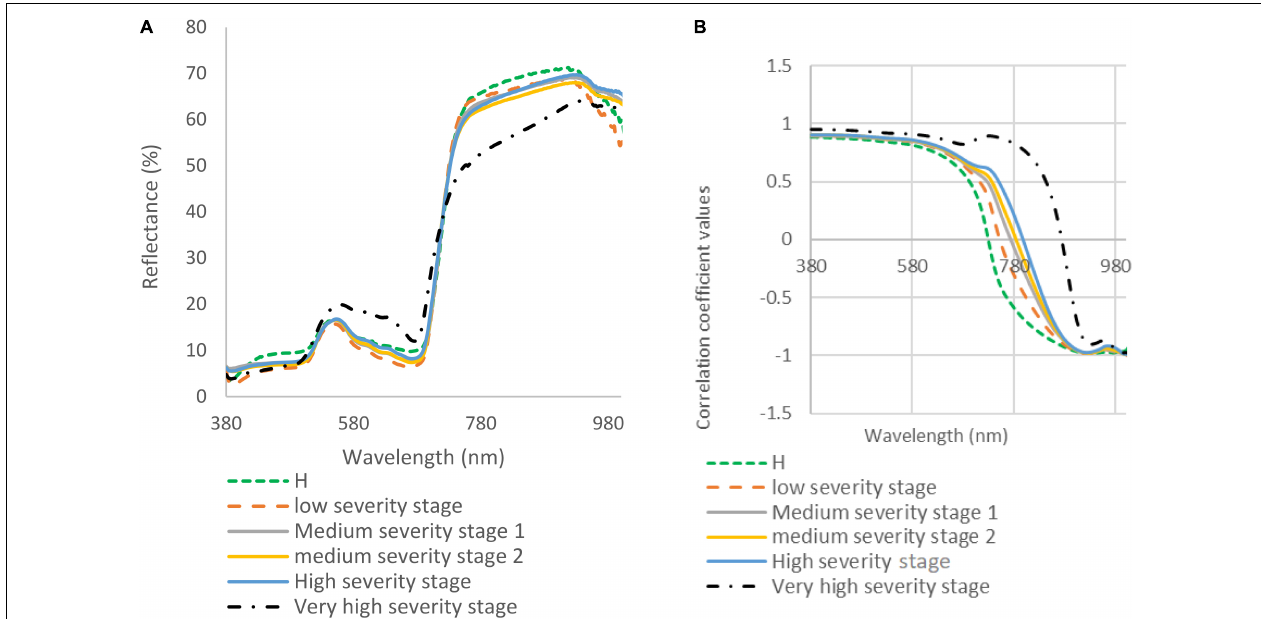
FIGURE 3 | (A) Spectral reflectance signatures (collected in the laboratory) of downy mildew affected watermelon leaves in five disease severity (DS) stages; and (B) correlation coefficient for watermelon leaves in healthy (H) and five DS stages.